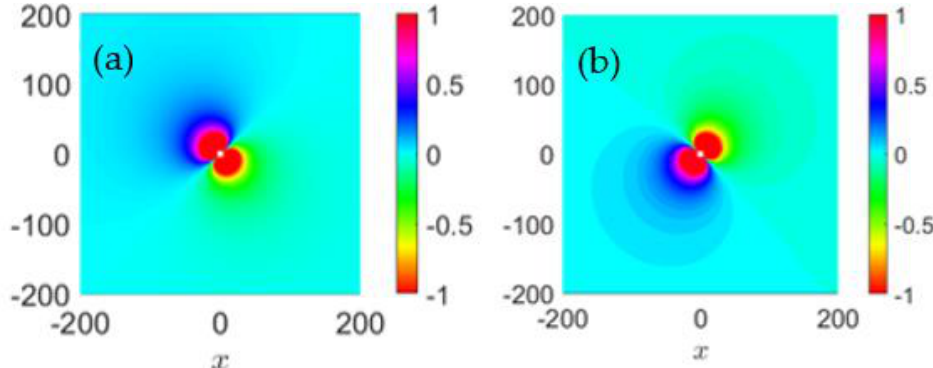
Equations (11) and (13) using the hydrodynamic loads of Figure 2b. The result in the near field is plotted at two instants, when the nose of the flapping thruster is directed upwards and downwards, respectively, and the field is normalized with respect to its value at the distance of 1 m from the source point.